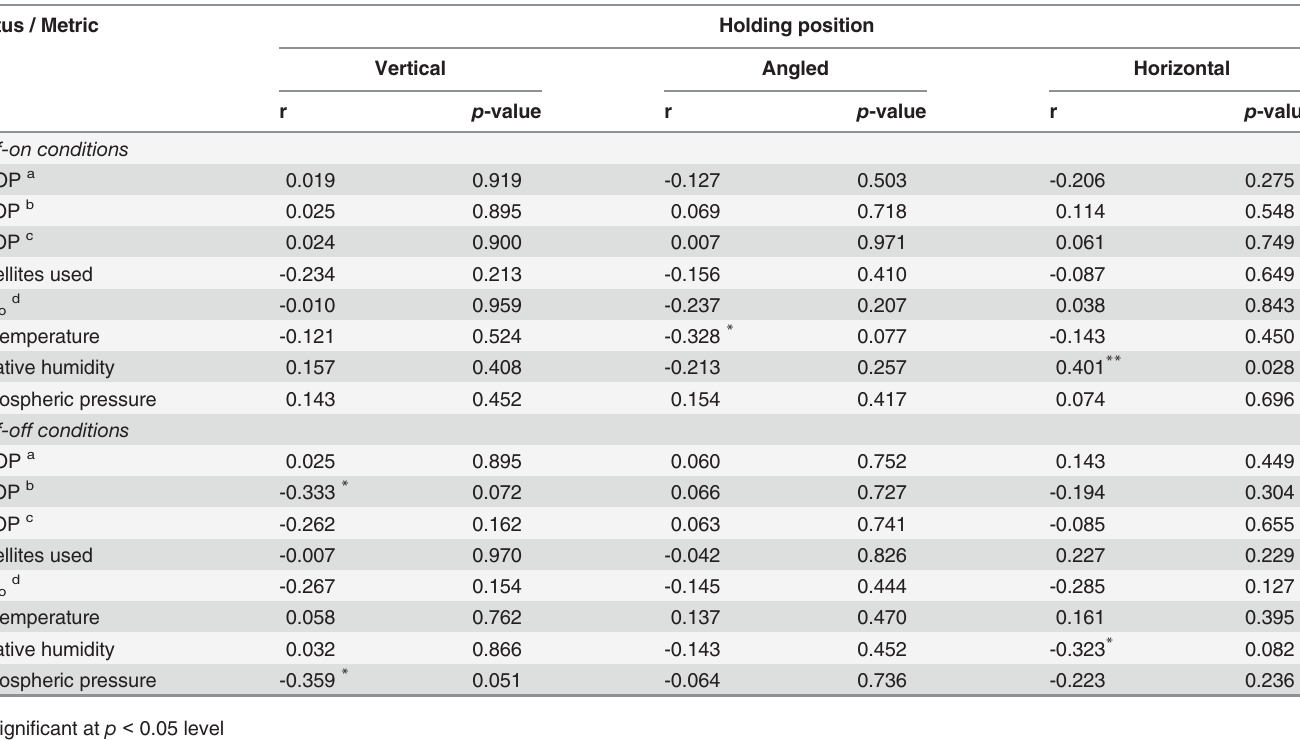
Table 6. Correlation between static horizontal position accuracy (as expressed by the root mean squared error of 30 samples) and other metrics of interest when using the Flint GNSS receiver in the deciduous